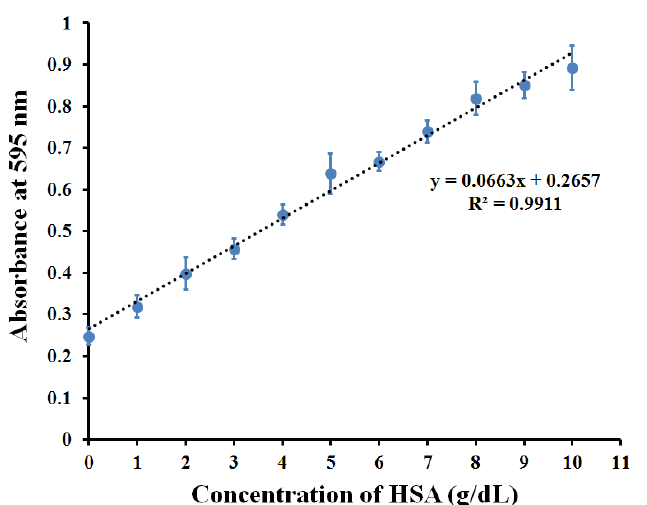
Figure 10. Calibration curve of HSA-MIP-based microplate assay determined with HSA solution.